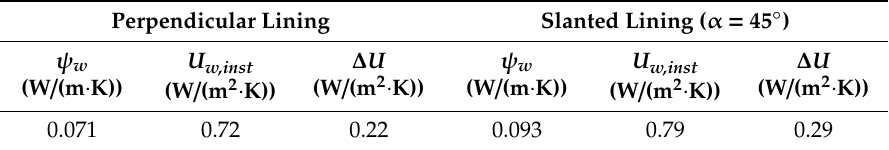
Table 6. E ff ects of thermal coupling for the perpendicular and slanted linings. Table 6. Effects of thermal coupling for the perpendicular and slanted linings.